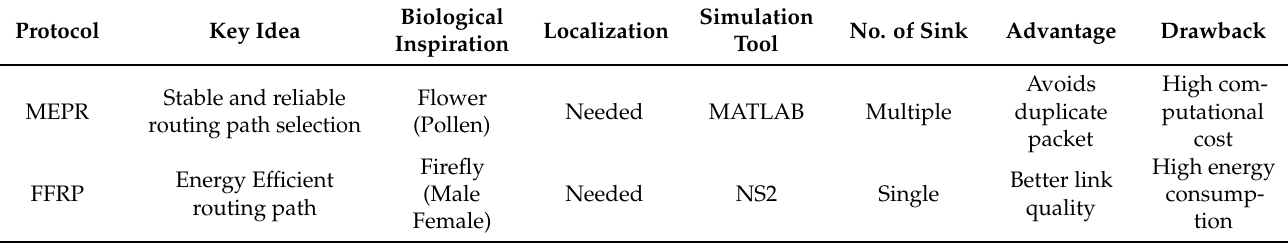
Table 8. Comparison of bio-inspired